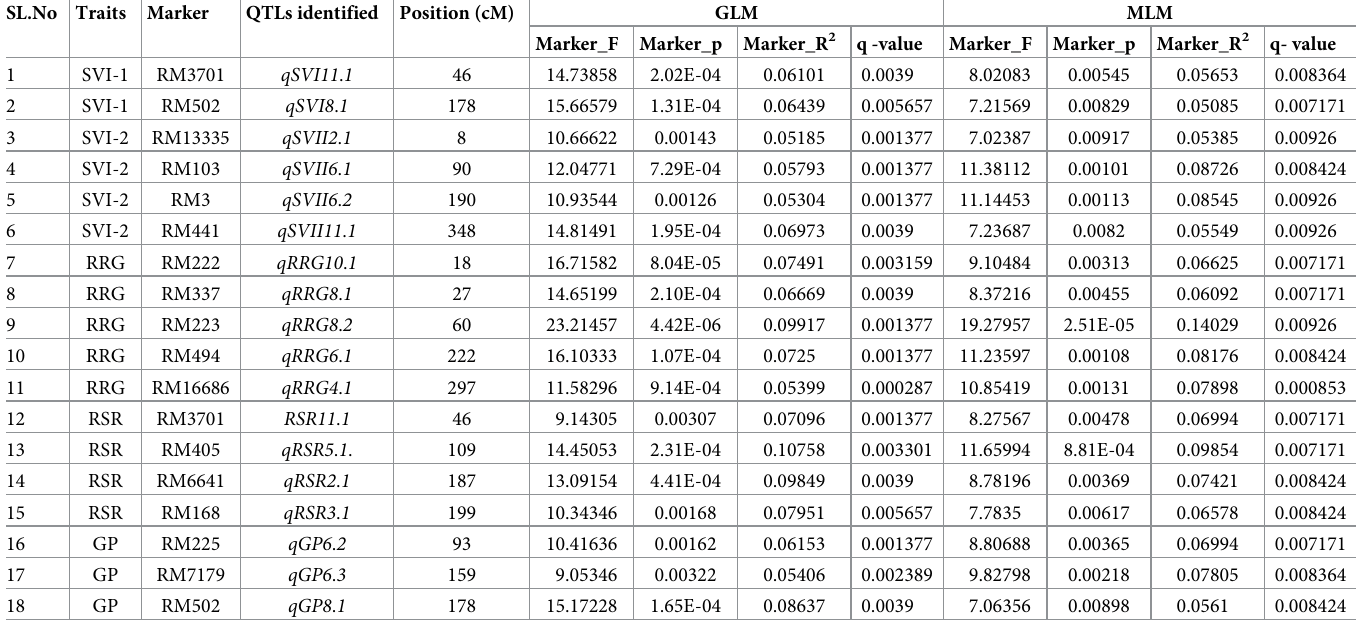
Table 3. Marker alleles association with seed vigour index, root parameters and germination per cent in ricelandraces present in the panel population detected by both the models of GLM and MLM analyses at p < 0.01. SL.No Traits